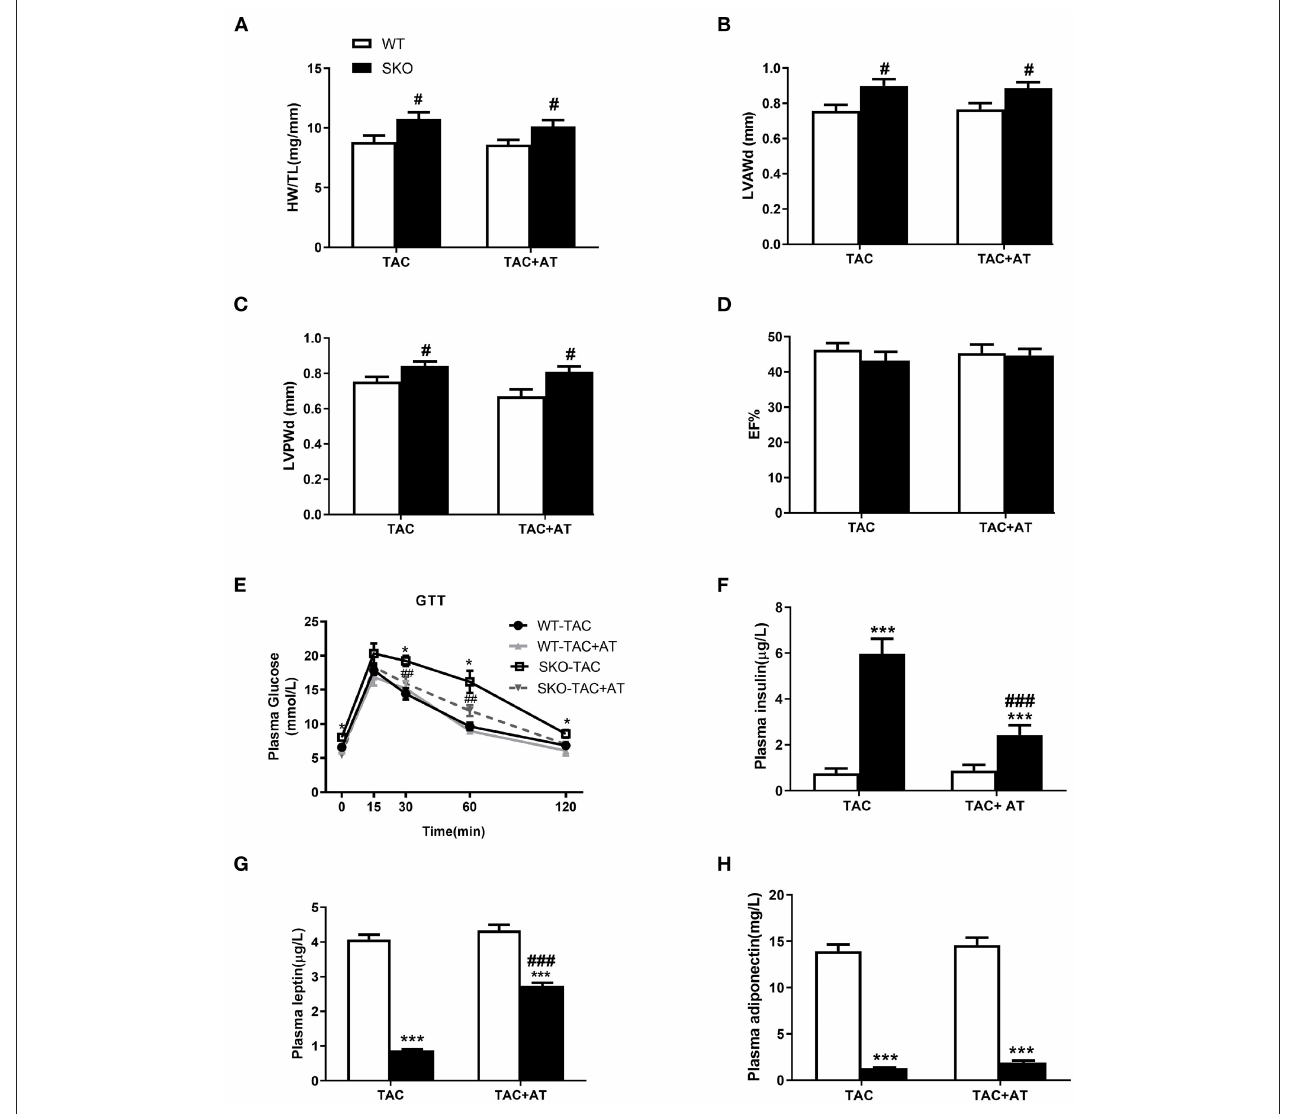
FIGURE 6 | AT transplantation did not rescue the cardiac hypertrophy after TAC in seipin deficient mice and improved of insulin resistance. (A) Ratio of heart weight/tibia length (HW/TL); (B) Left ventricular anterior wall thickness in diastole (LVAWd); (C) Left ventricular posterior wall thickness in diastole (LVPWd); (D) Ejection fraction (EF %); (E) Glucose tolerance test (GTT) results; (F) plasma levels of insulin; (G) leptin; and (H) adiponectin. * P < 0.05, *** P < 0.001, effect of AT transplantation; # P < 0.05, ## P < 0.01, ### P < 0.001, effect of genotype. AT, Adipose tissue; WT, Wild-type; SKO, Seipin knockout; TAC, transverse aortic